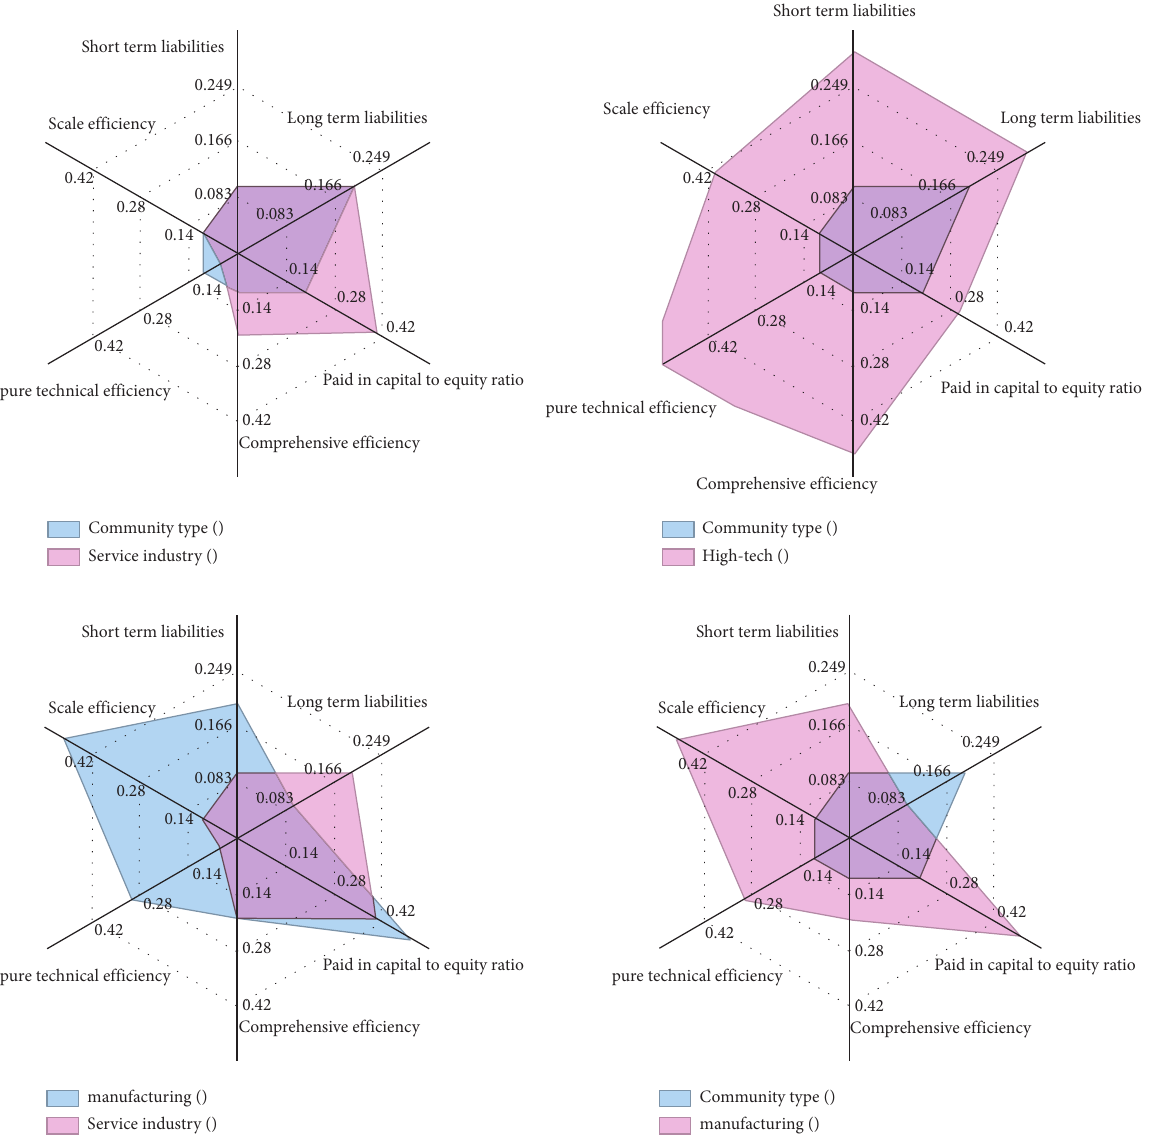
Figure 9: Impact of enterprises under multiple